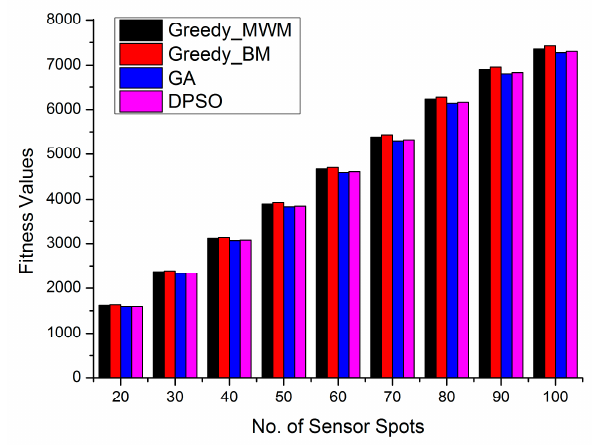
Figure 7. Fitness values of the greedy algorithms, GA, and DPSO algorithm.